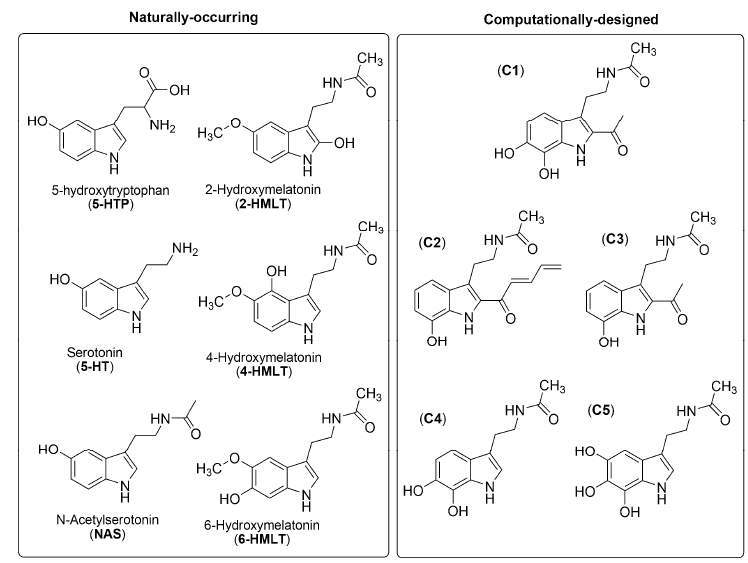
Figure 2. Phenolic melatonin-related compounds analyzed in this review.